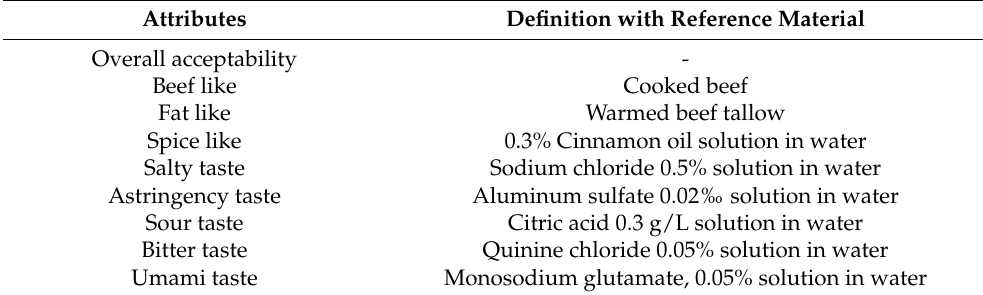
Table 2. The corresponding references of odors and